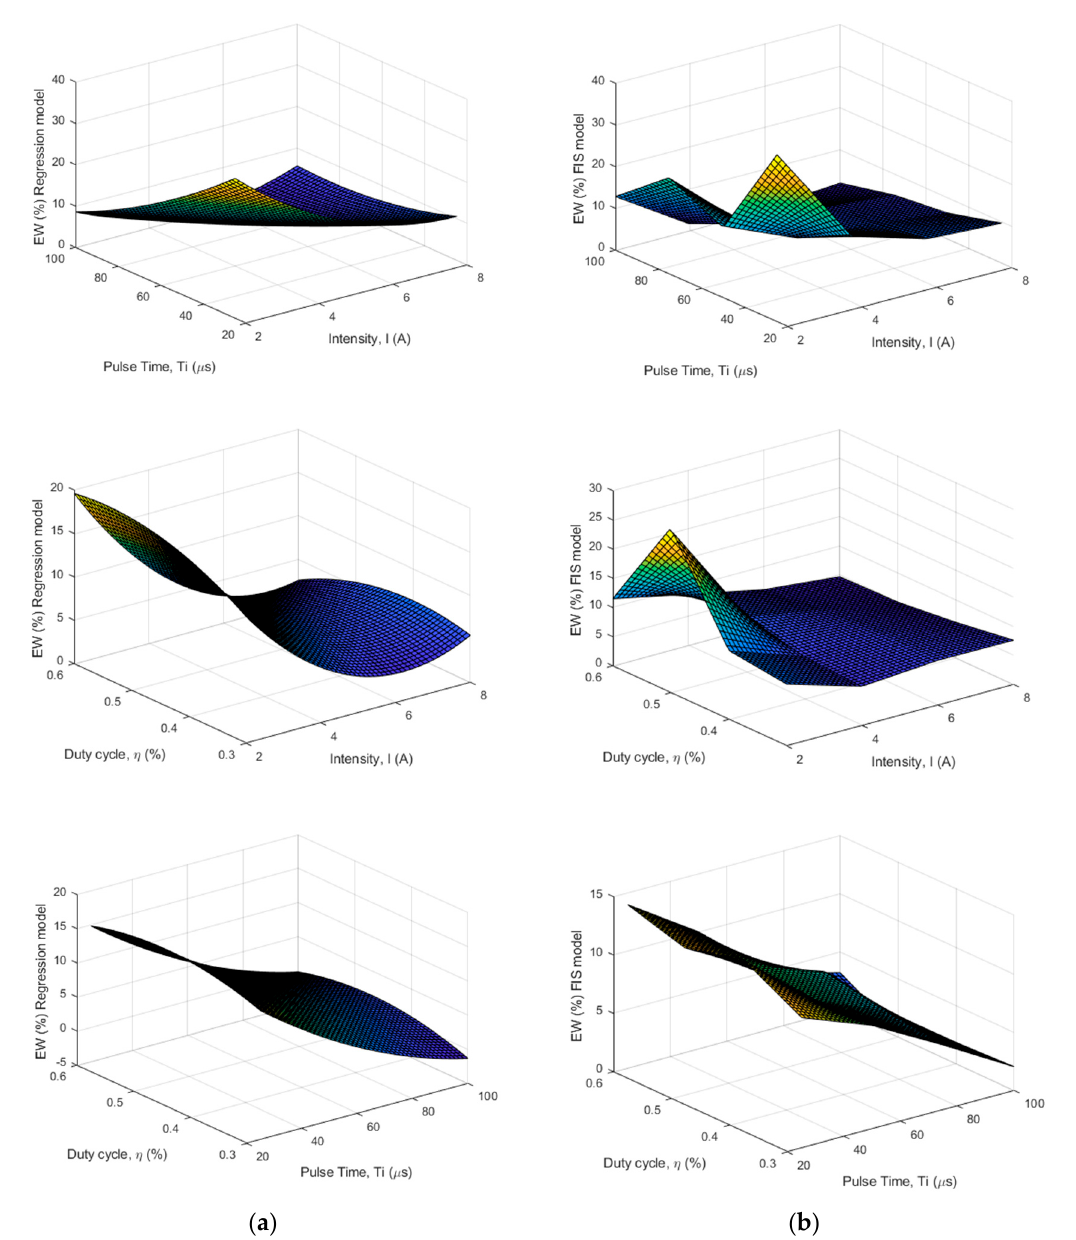
Figure 5. Response surfaces for EW in the case of positive polarity: ( a ) obtained from the regression [2]; ( b ) obtained with the proposed methodology using the FIS.